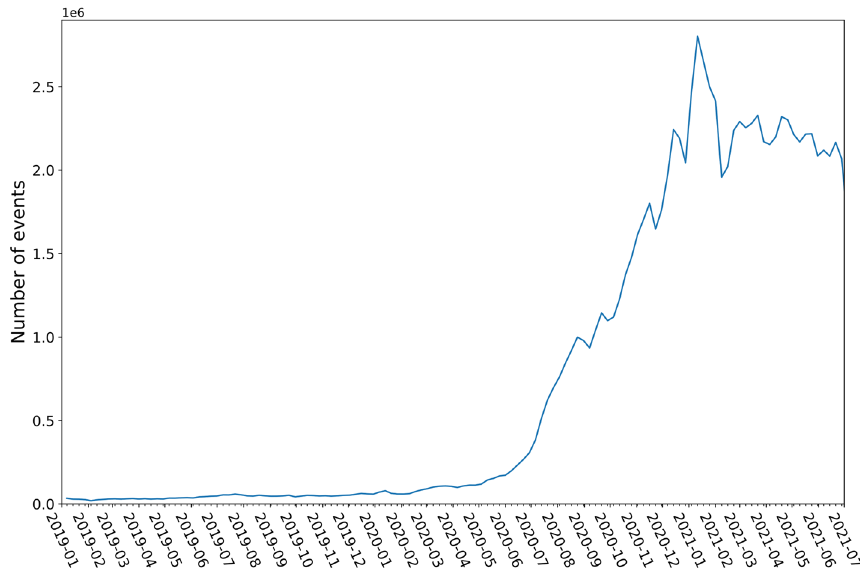
Fig. 6 Weekly number of events in the data set. Source : Own